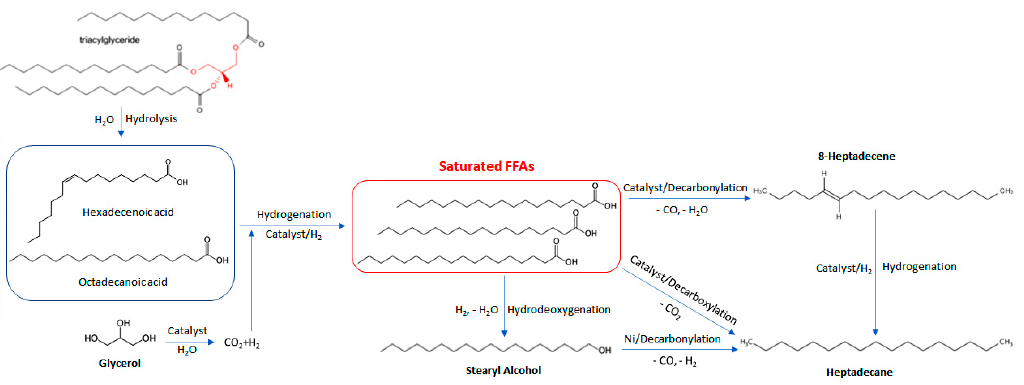
Figure 6. HTL conversion pathway of triacylglycerides to linear alkanes in the presence of Fe- Ni/Al 2 O 3 catalyst.